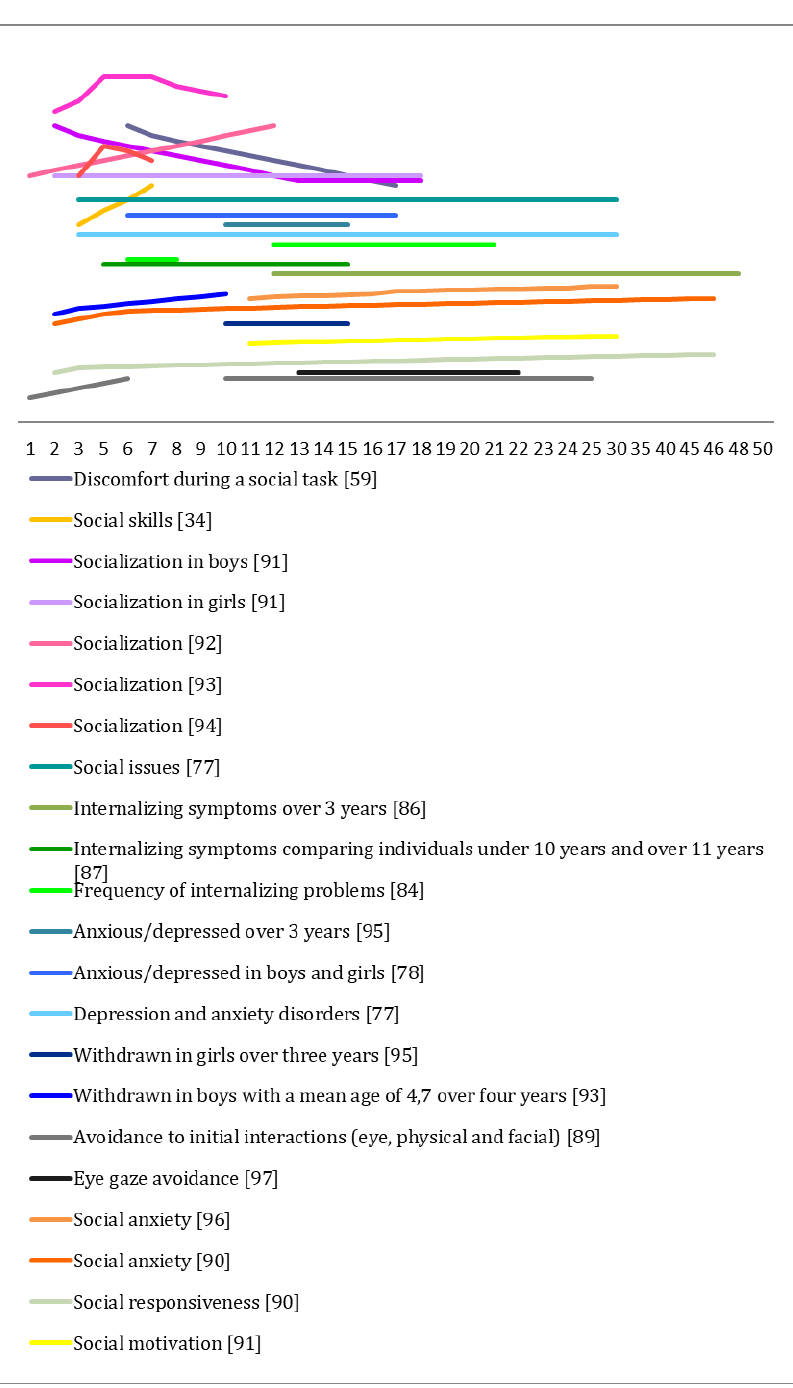
Figure 2 Figure A2. Trajectories of social competence from the studies reviewed. This graph provides descrip- tive information of the trajectories reported in the studies reviewed [34,59,77,78,84,86,87,89–97]. The Y-axis has been removed because of the use of different measures and comparisons not being possible. Higher or lower lines do not represent greater problem behaviors or a higher frequency of behavior problems, nor does the slope. Each line should be compared with itself. For example, in this graph, social anxiety and social skills increase over the years, but scores for social skills are not higher than those of social anxiety, nor do social skills increase faster over the years. One finding from the graph is that social skills increased from 3 to 6 years in